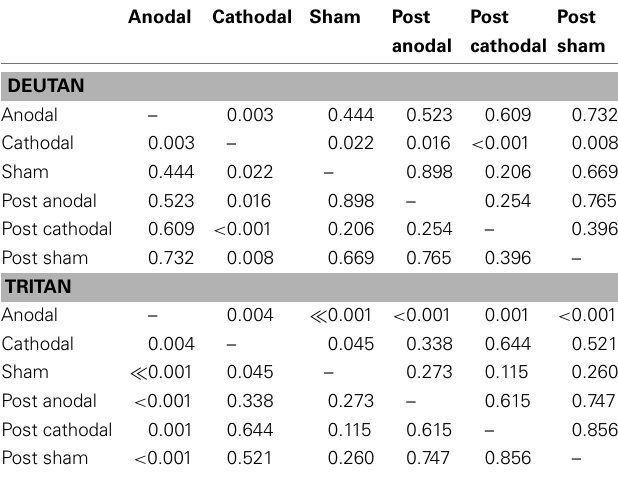
Table 1 | Significance values for comparisons of deutan and tritan